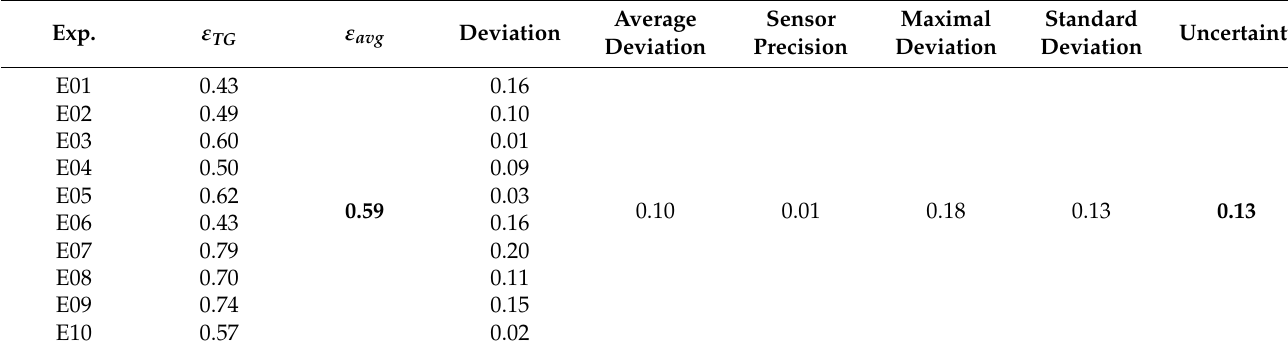
Table 5. Obtained long-wave emissivity for the samples. Average Sensor Maximal Standard Deviation Deviation Precision Deviation Deviation